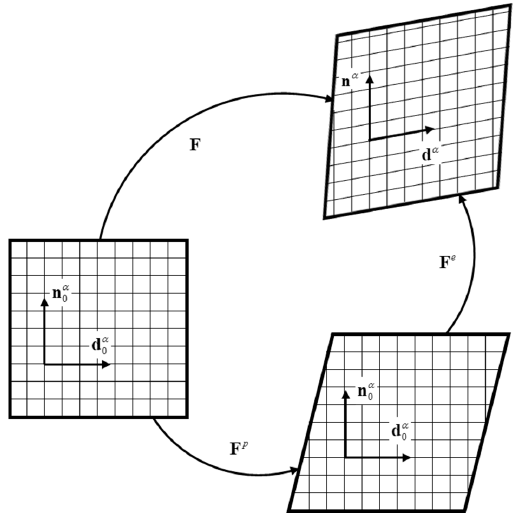
Figure 2. Schematics of multiplicative decomposition of deformation gradient.